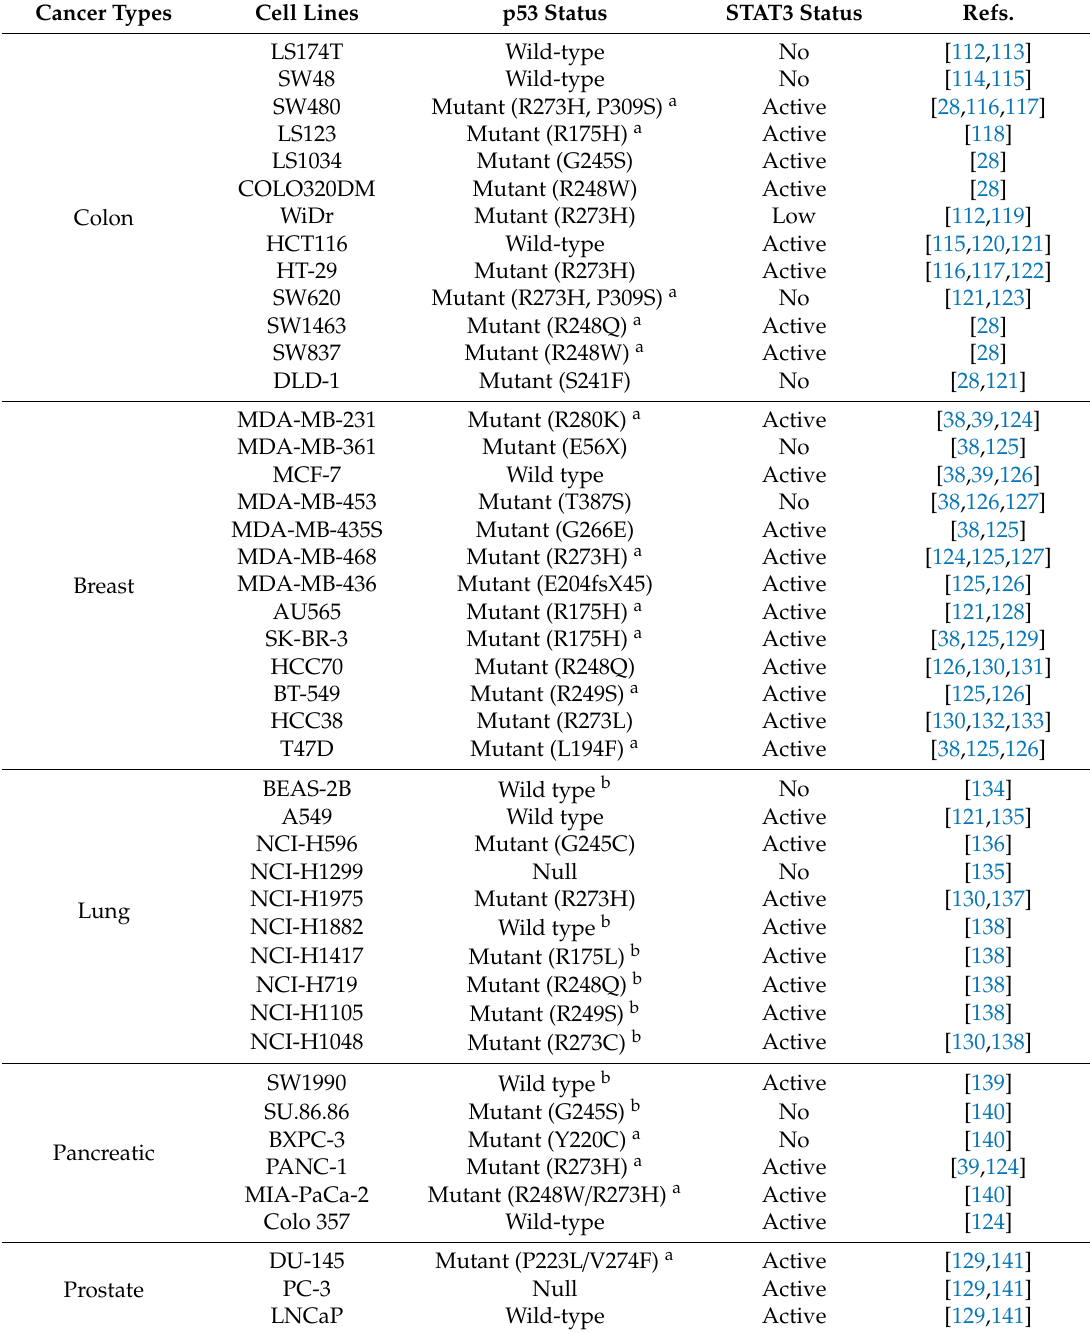
Table 1. The status of p53 mutation and transcription 3 (STAT3) constitutive activation in human cancer cell